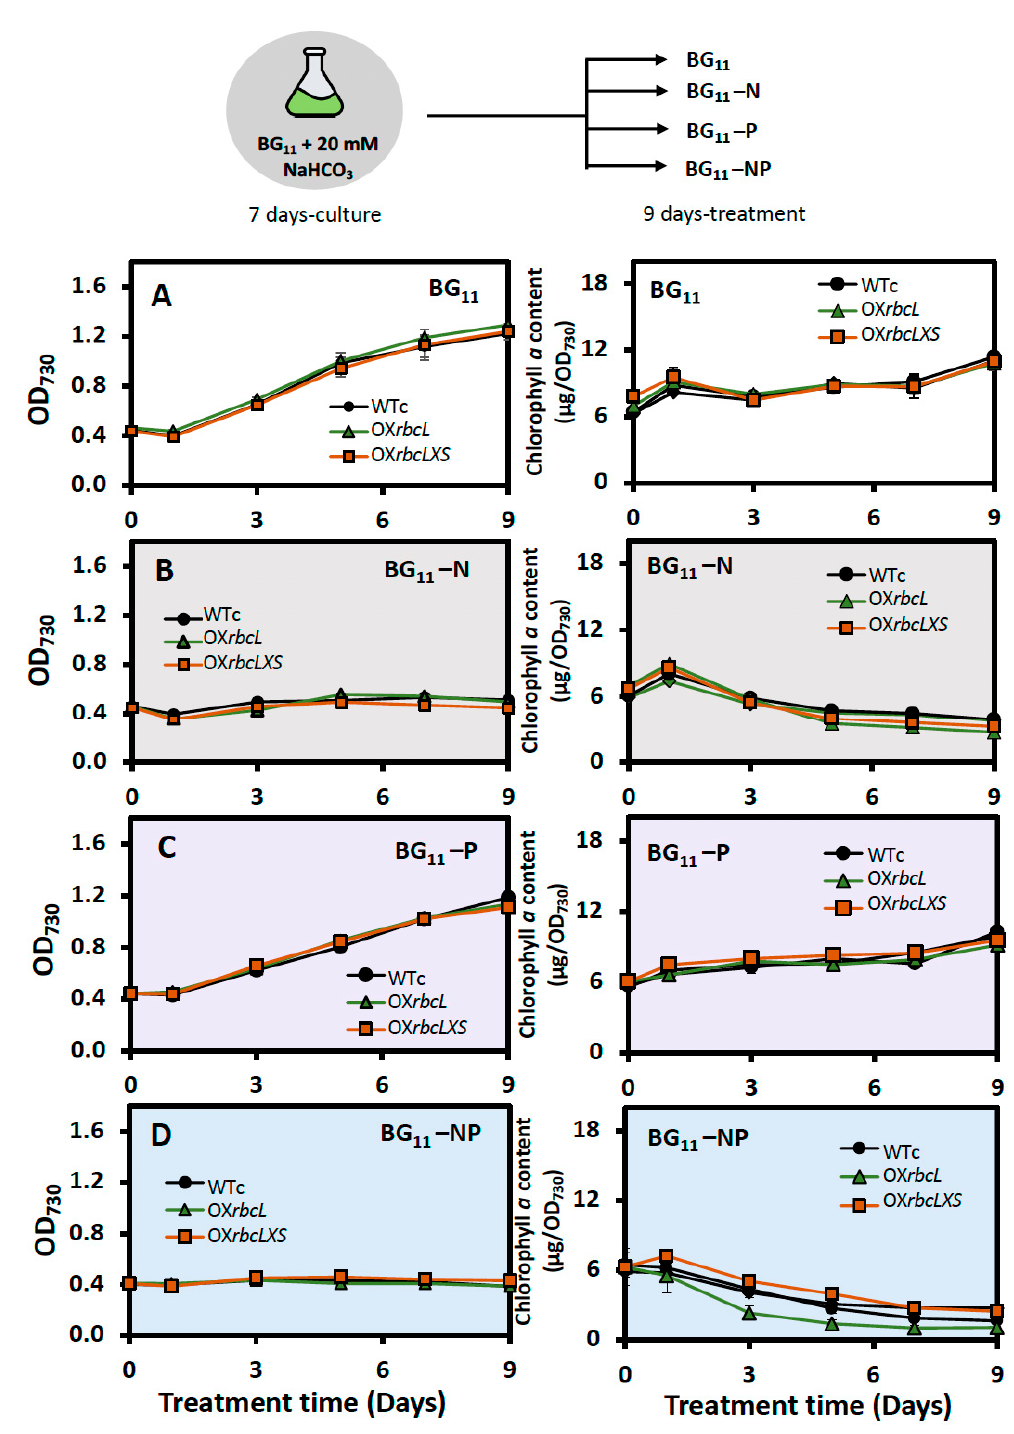
Figure 5. Optical density at 730 nm and chlorophyll a content of Synechocystis WTc, OX rbcL , and OX rbcLXS strains after adapting in ( A ) normal BG 11 medium, ( B ) BG 11 -N, ( C ) BG 11 -P, and ( D ) BG 11 -NP for 9 days. The error bars represent standard deviations of means (means ± S.D., n = 3).